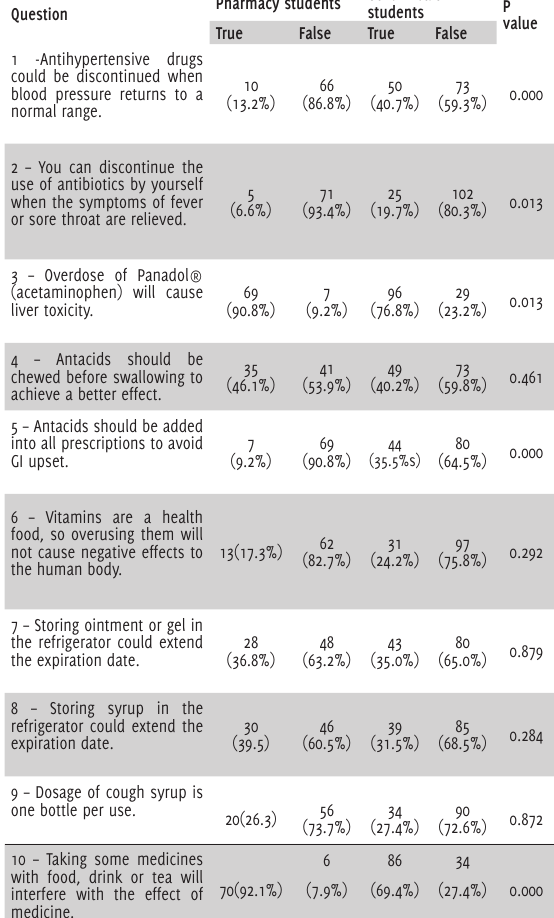
Table 3. Attitudes of pharmacy, nursing, applied medical science, medical, and dentistry by mean and standard deviation towards medication consulta- tion by pharmacists (N=204).